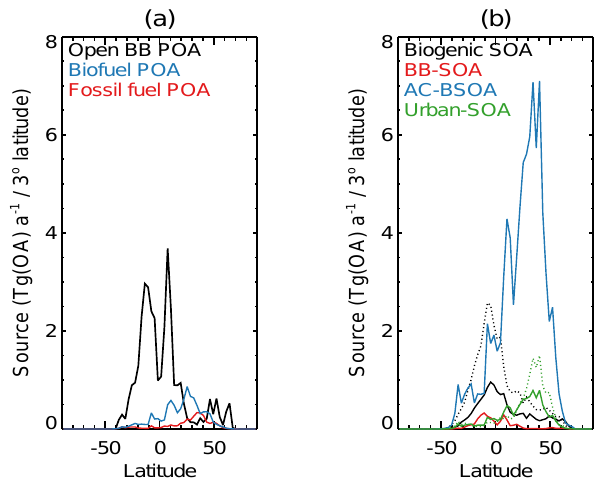
Fig. 11. Zonal mean distribution of (a) POA and (b) estimated SOA sources: biomass burning (BB-SOA); anthropogenically controlled biogenic SOA (AC-BSOA). Sources of SOA estimated in this work (solid lines) are plotted for comparison against sources estimated by de Gouw and Jimenez (2009) (dotted lines). POA emissions in the two studies are